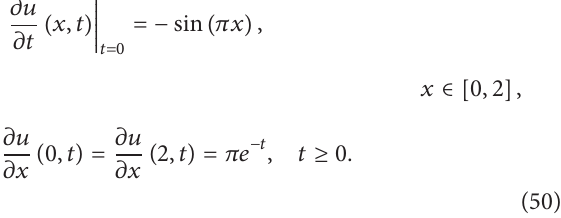
Figure 1: Convergence rate of two different schemes for Example 1 in 𝑡 = 2.0 .